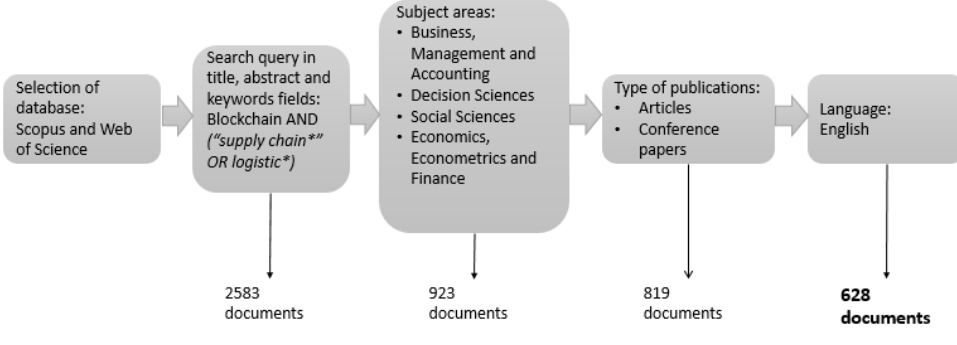
Figure 1. Search and selection process.